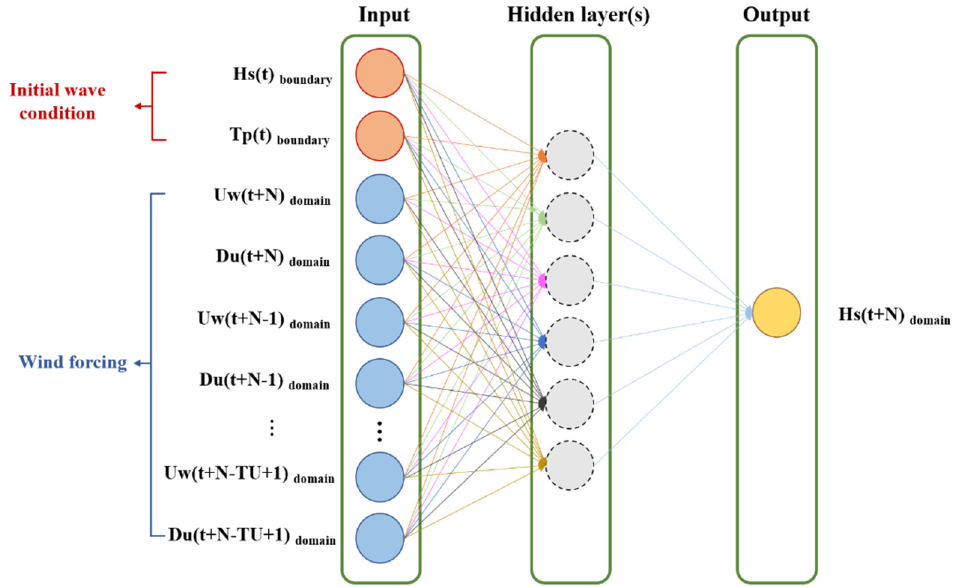
Figure 3. Illustration of the PBML (Physics-Based Machine Learning) model architecture.